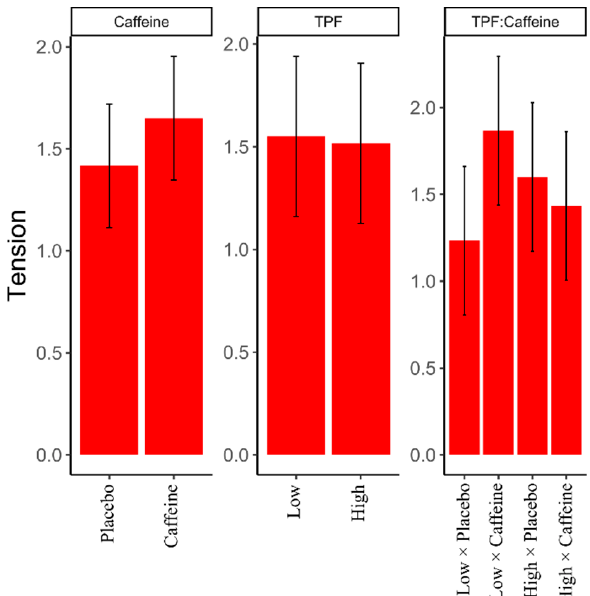
Figure 4. Profile of Mood Survey (POMS) Tension score changes. TPF = Trait Physical Fatigue. Data are presented as means ± standard deviations.